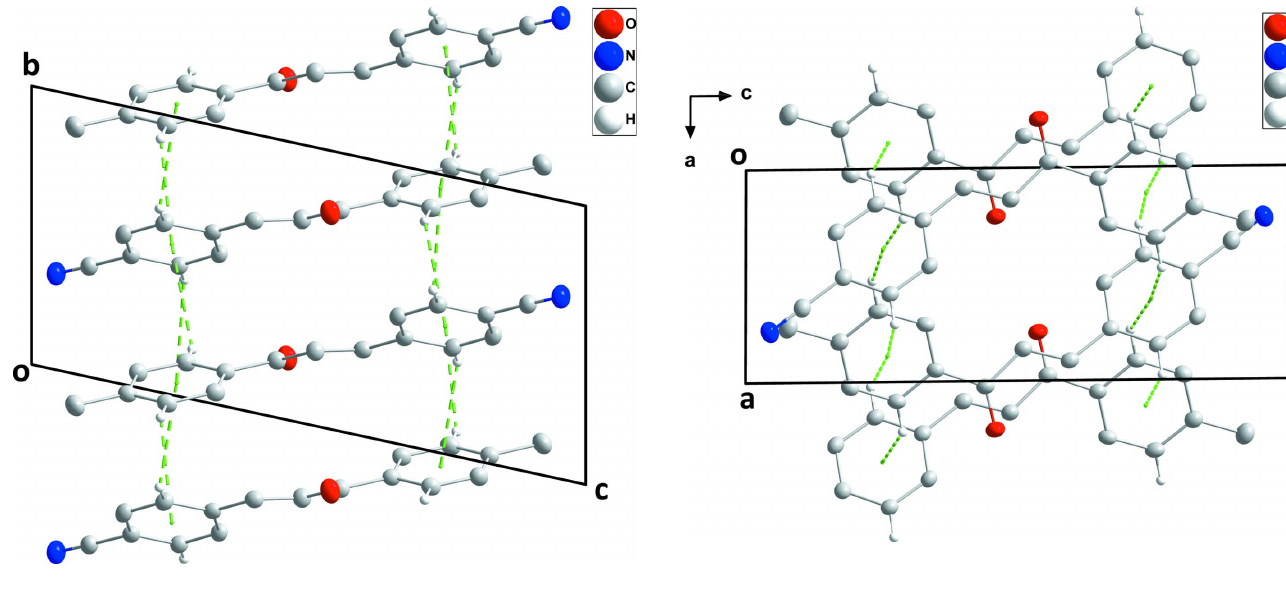
Figure 3 View of a portion of one layer viewed along the b -axis direction with C—